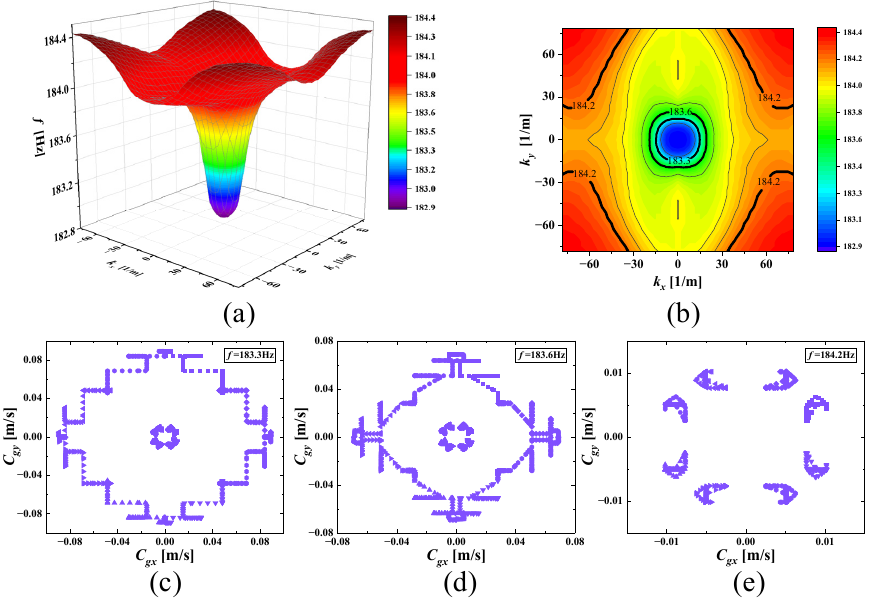
Figure 6. ( a ) Third mode; ( b ) ISO-frequency contours (the thick black solid lines are the three selected frequencies to be analyzed and similar depictions can be seen in Figures 7–12); ( c – e ) group velocity of third wave mode at 183.3 Hz, 183.6 Hz, and 184.2 Hz.